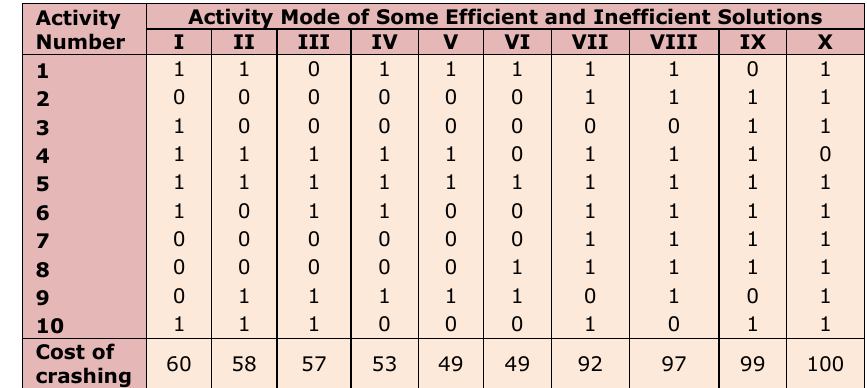
Figure 2. Snapshot of implementation on electronic spreadsheet